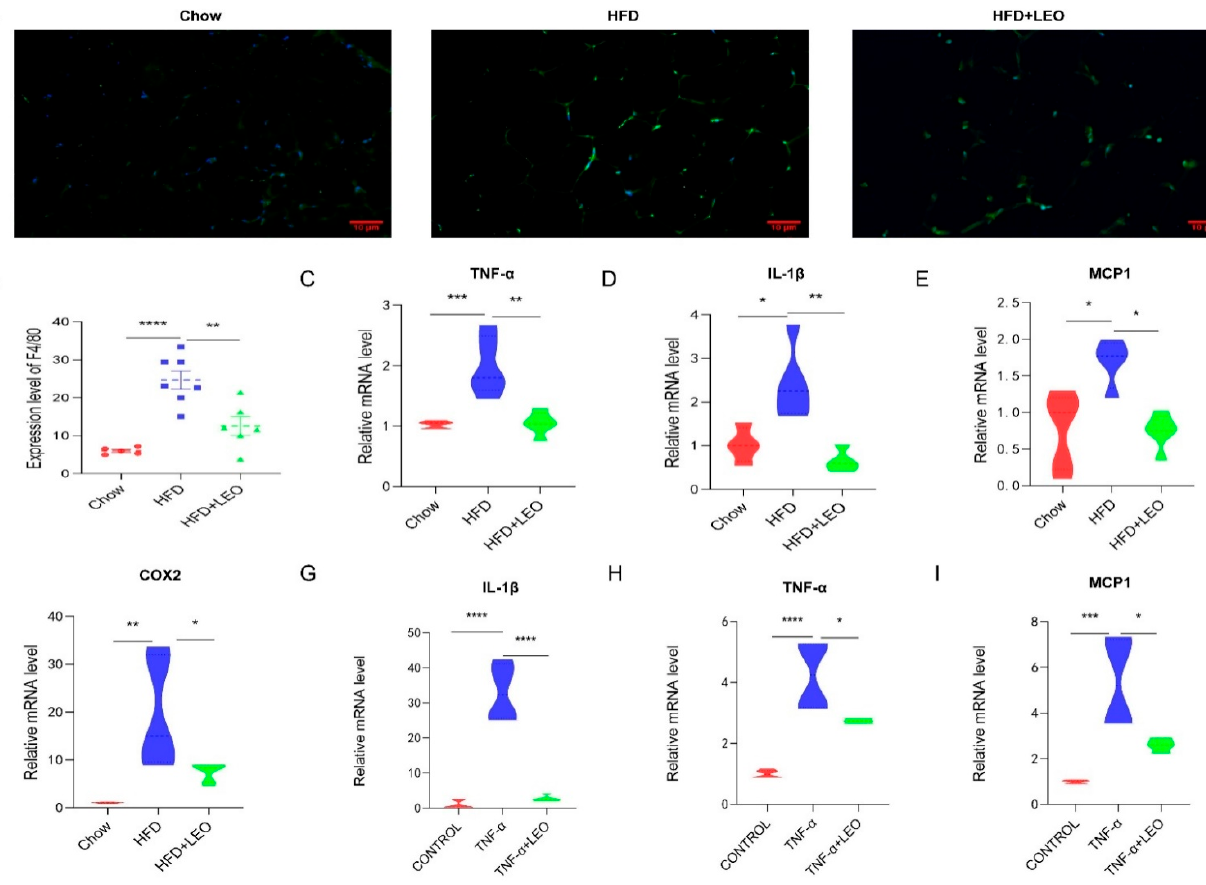
Figure 2. LEO improves inflammation. ( A ) Representative immunofluorescence pictures of the expression and nuclear translocation of F4/80 in three groups’ EWAT. ( B ) Quantitative analysis of the ratios of F4/80. ( C – F ) mRNA expression of TNF- α , IL-1 β , MCP-1, and COX-2 in the EWAT; n = 5 mice per group. ( G – I ) mRNA expression of TNF- α , IL-1 β , and MCP-1 in the RAW264.7 cells treated with 100 ng/mL of TNF- α with or without 20 μ M of LEO for 8 h. Data are shown as means ± S.E.M. * p < 0.05, ** p < 0.01, *** p < 0.001, and **** p < 0.0001 between groups.